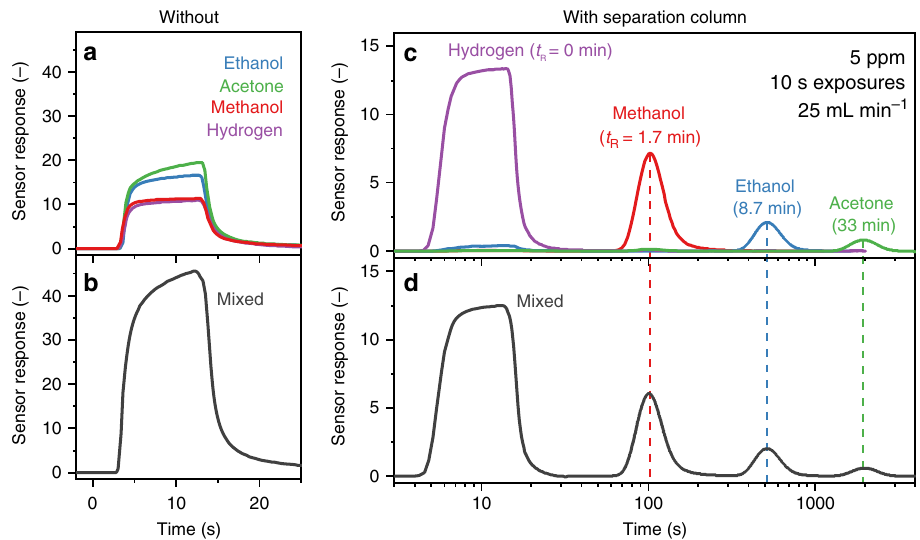
Fig. 2 Single and mixed analyte responses without and with separation column. Response of the methanol detector a , b without and c , d with separation column to 10 s exposures of 5 ppm hydrogen (purple line), methanol (red line), ethanol (blue line), and acetone (green line) as well as their mixture (black line in b and d ) at 50% RH and 25 mL min − 1 total fl ow rate. Also given are the corresponding retention times ( t R , dashed lines, for hydrogen t R = 0 min as it is not retained). Note the different ordinate scale between a , b and c , d . The presence of the polymer sorbent packed bed upstream of the Pd-doped SnO 2 sensor facilitates the separation of the mixture